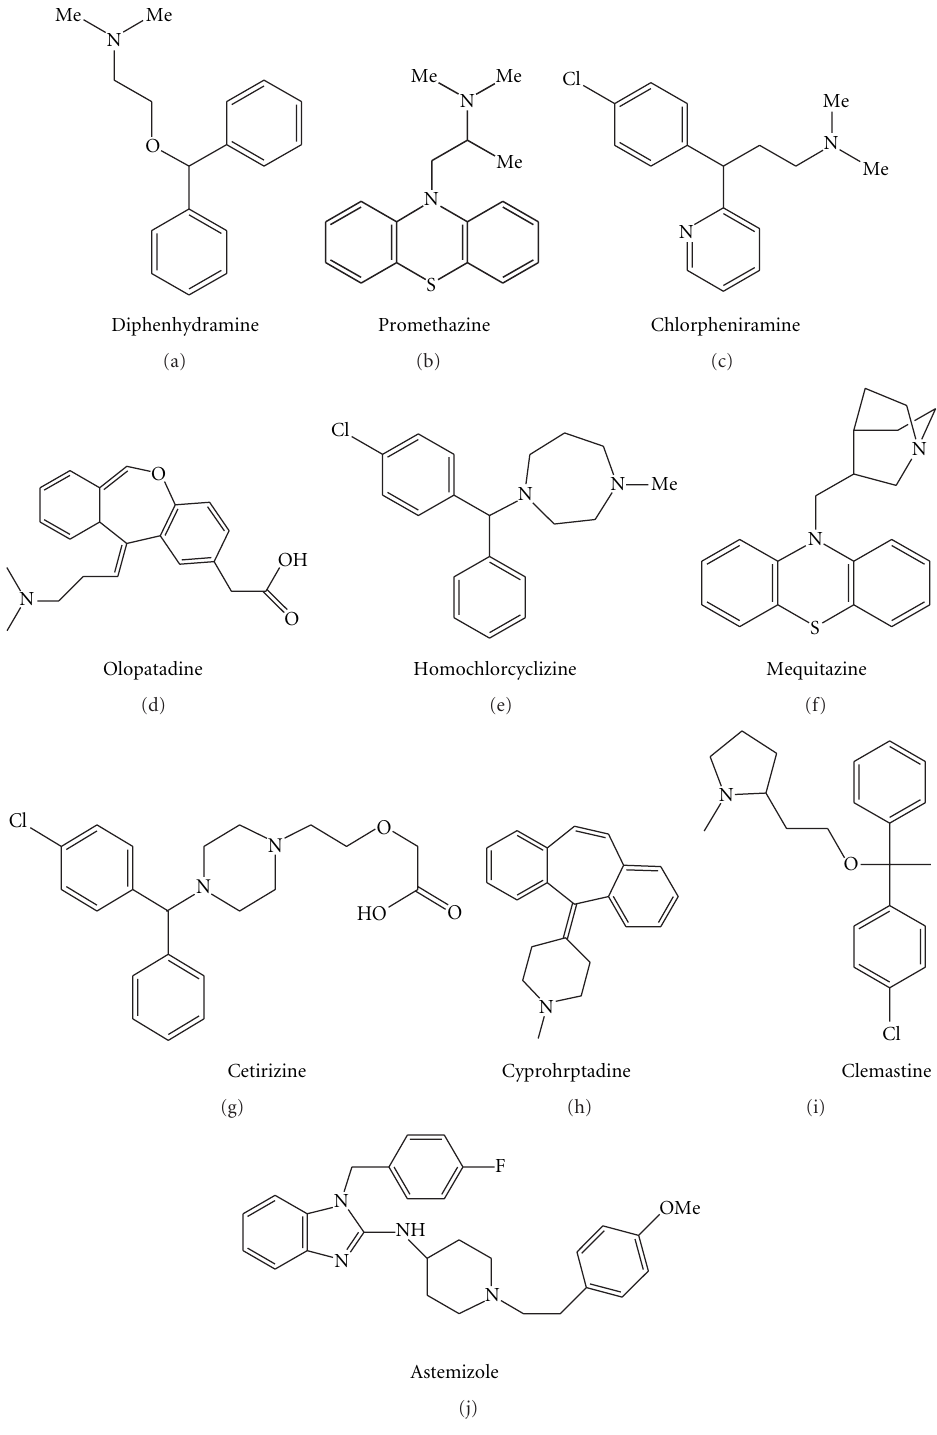
Figure 4: Histamine H1 receptor antagonists.